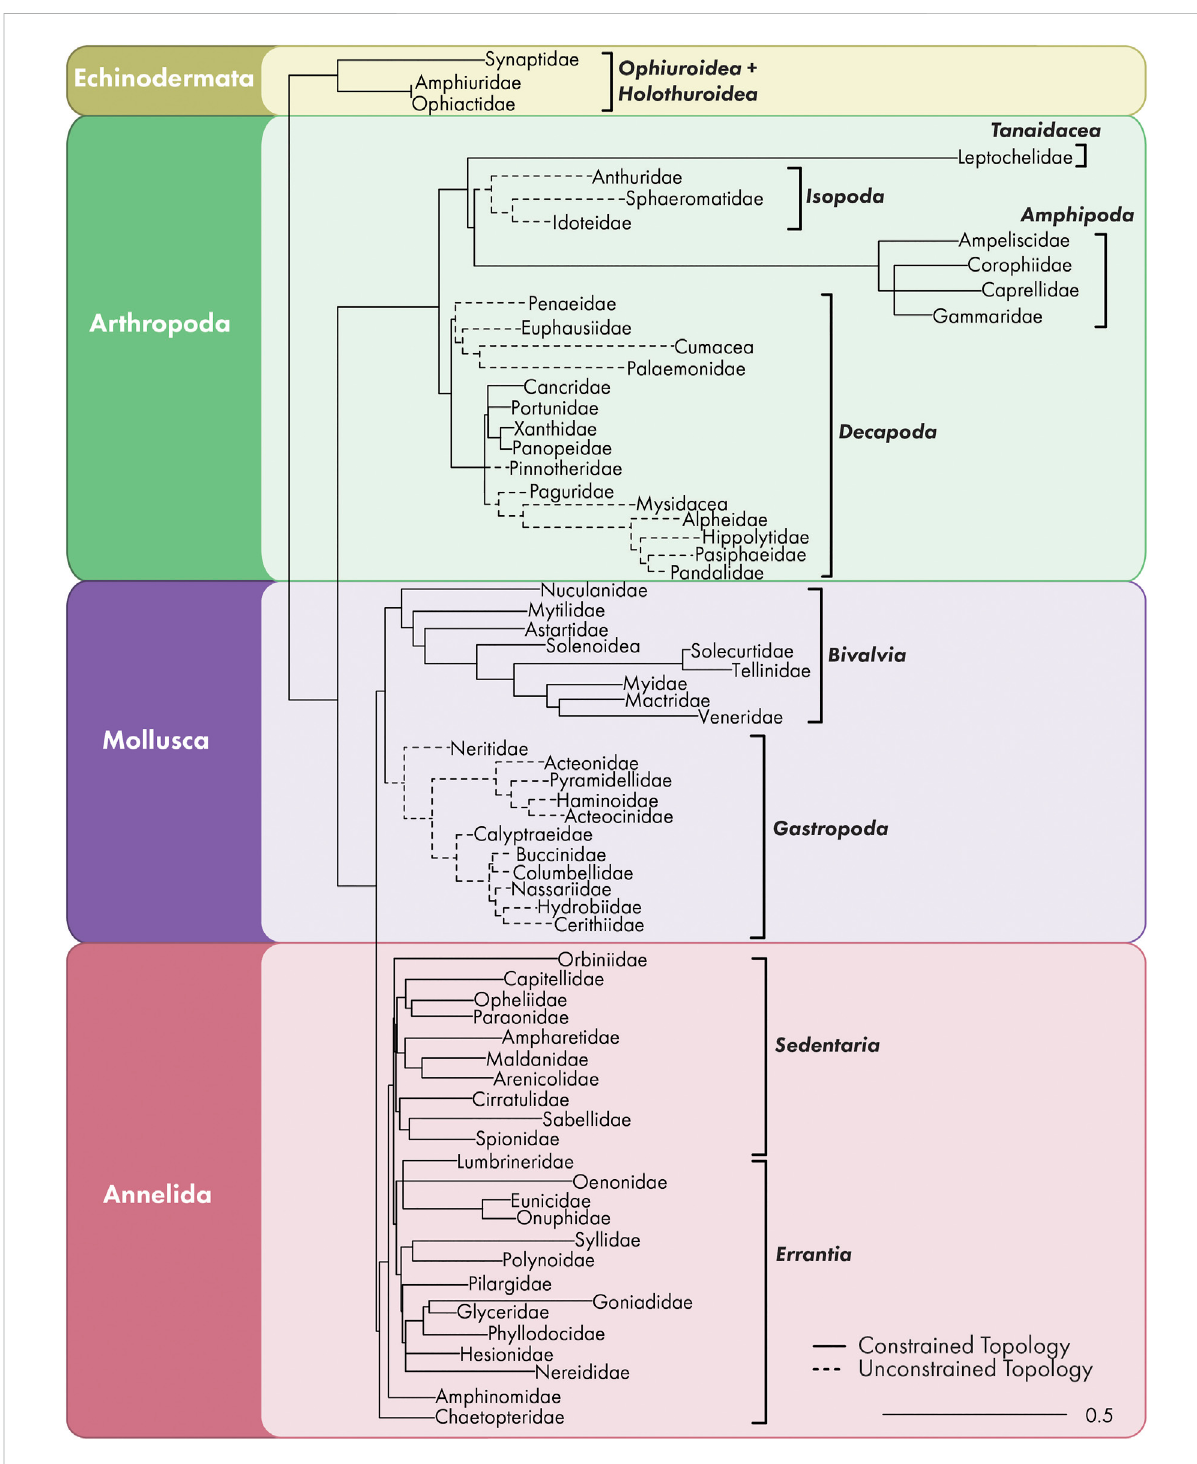
FIGURE 2 Comprehensivefamily-levelMLphylogenetictreeshowingall70familiesidenti fi edduringsamplingatbothoiledandunoiledlocations.Dashed branches indicate families were not constrained during tree